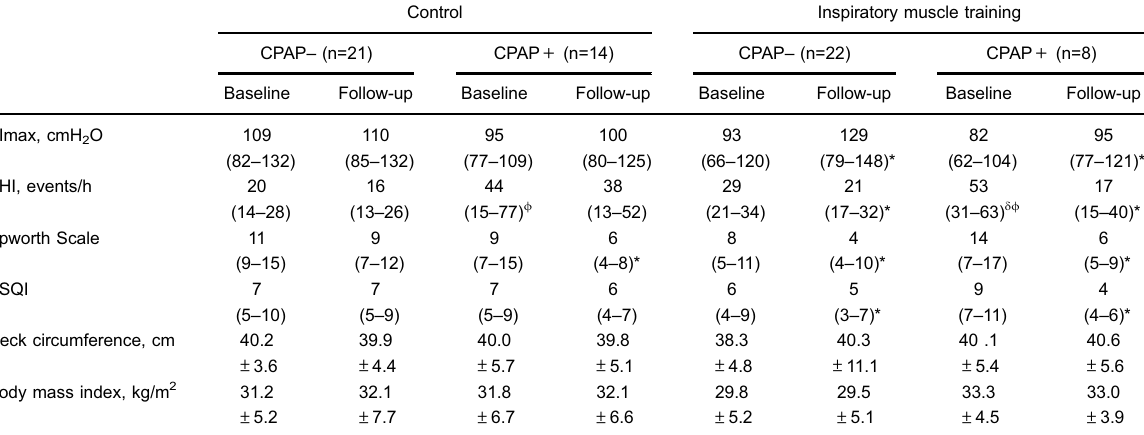
Data are reported as medians and interquartile range or mean ± SD. f P o 0.05 vs baseline CPAP – in the same group; d P o 0.05 vs baseline CPAP – in the control group; *P o 0.05 vs baseline of the same subgroup (signed rank (Wilcoxon) test, Kruskall-Wallis ANOVA